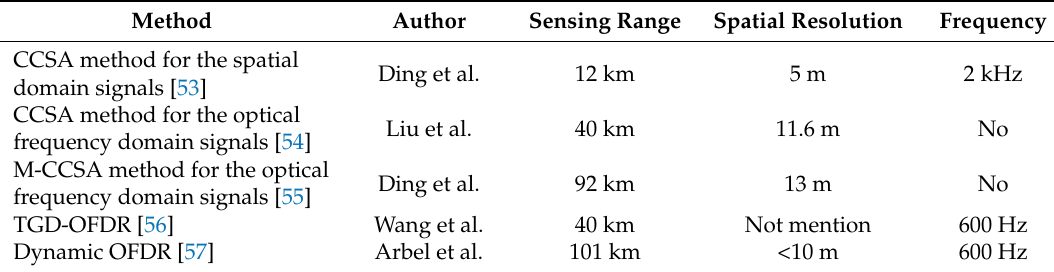
Table 2. Performance summary of DVOFS based on